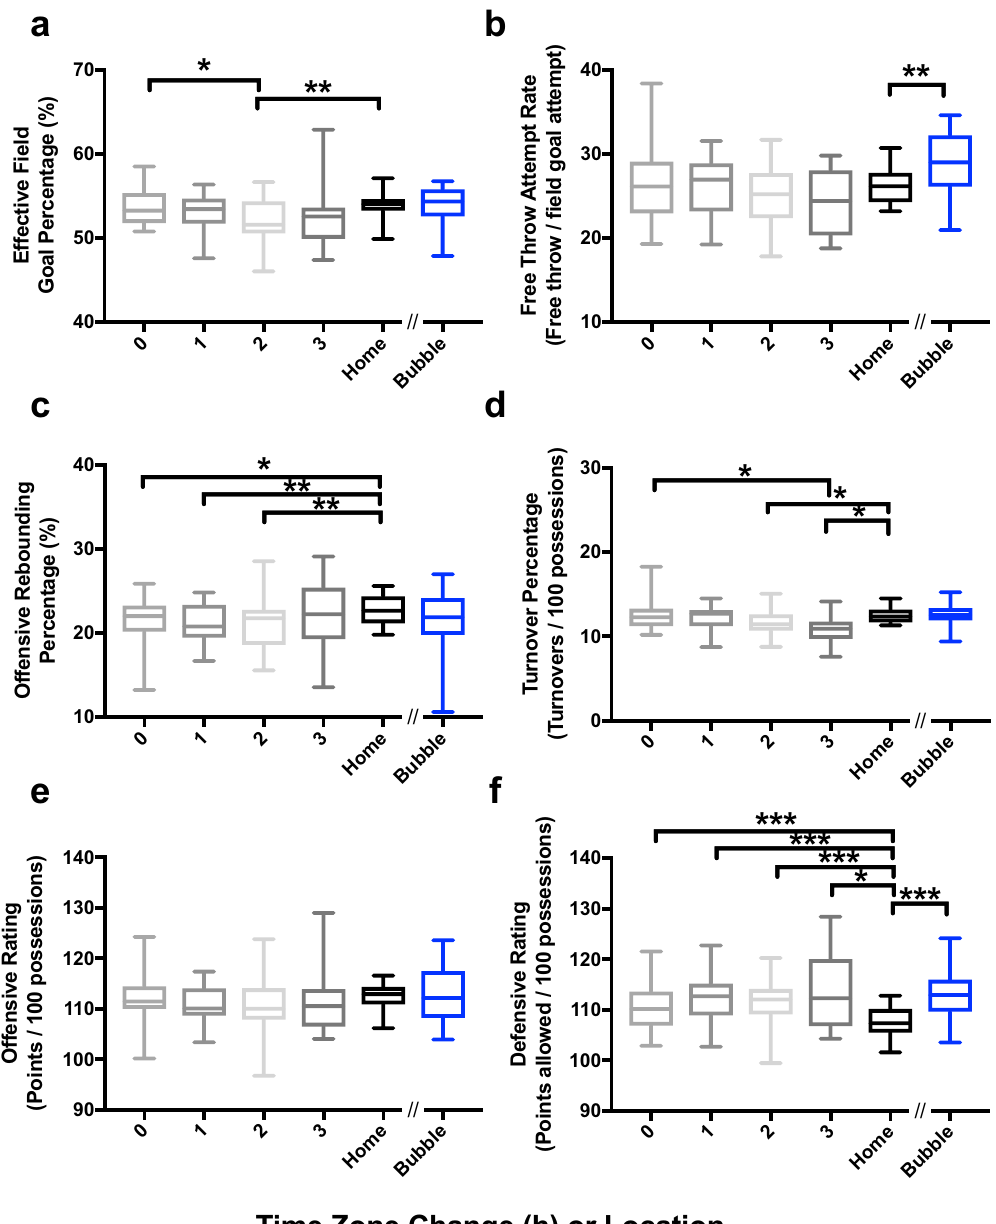
Figure 2. Advanced in-game metrics when playing at home and away (by time-zone change) in pre-COVID-19 games, and all games (combined home and away) in the restart bubble with no travel. The bubble games were only compared with the pre-COVID-19 home games. Brackets with asterisks denote significant differences at the end of each line; *denotes p < 0.029, **denotes p < 0.01, ***denotes p < 0.001. Error bars are standard error of the